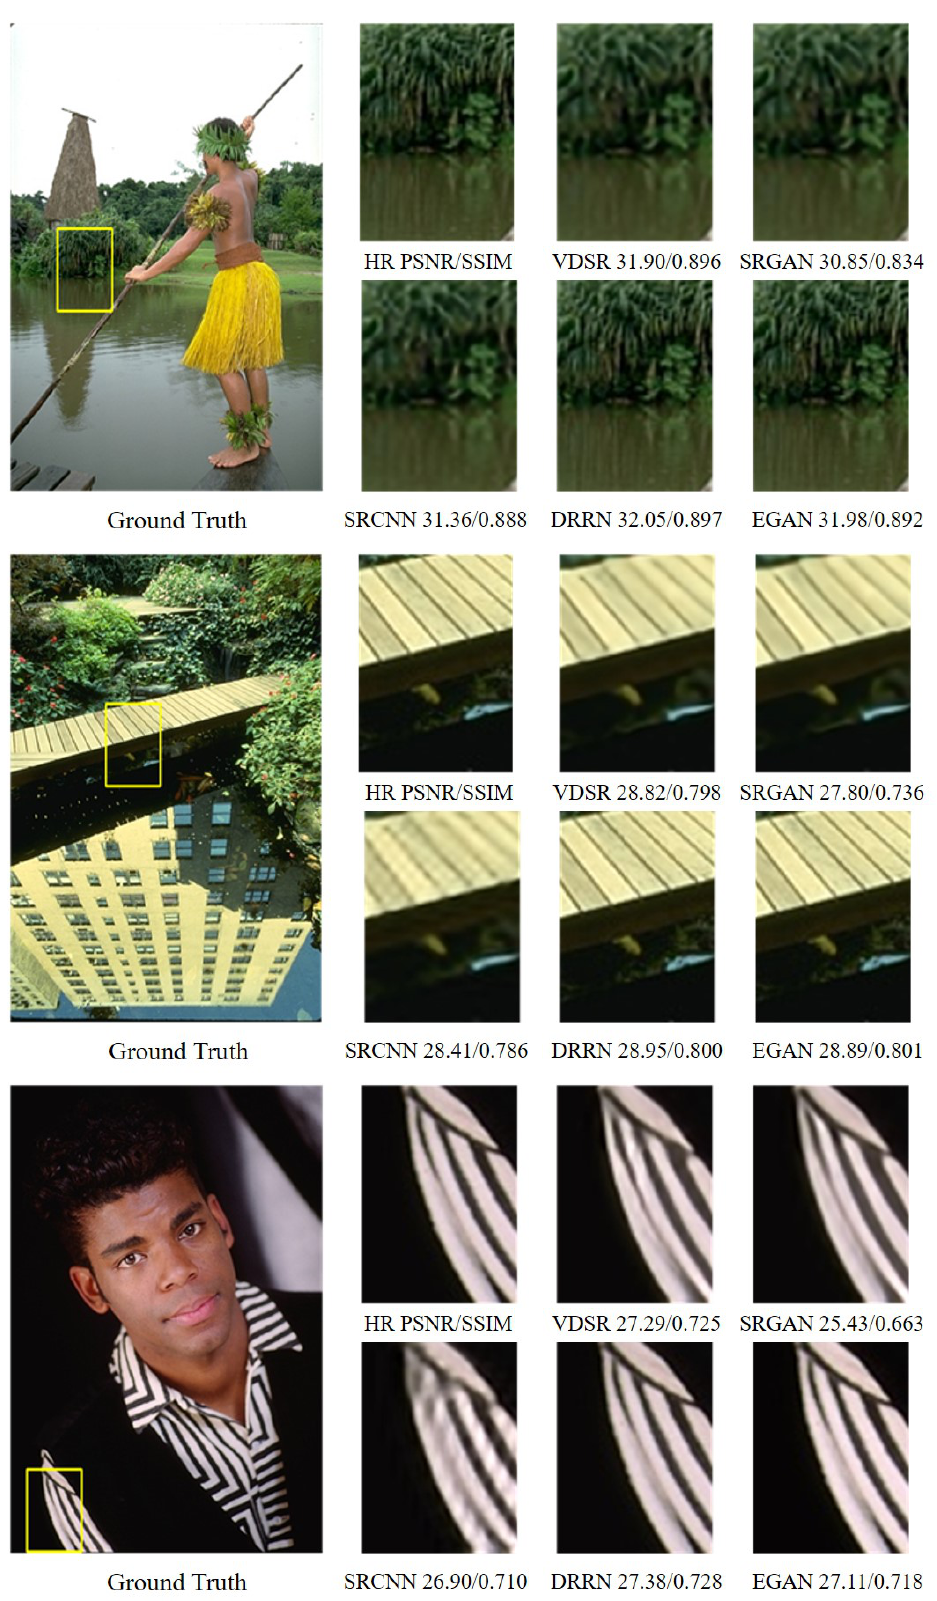
Figure 9. Visual comparisons for ×2, ×3, and ×4 SR on BSD100, image “101087” with scale factor ×2, image “148026” with scale factor ×3, and image “302008” with scale factor ×4 are shown, respectively, in the 3